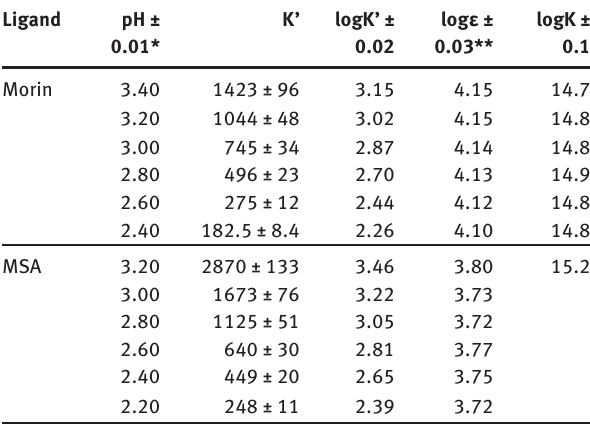
Table 1: The conditional (K’), true (K) stability constants, and extinctions (ε) for morin-Pb 2+ and MSA-Pb 2+